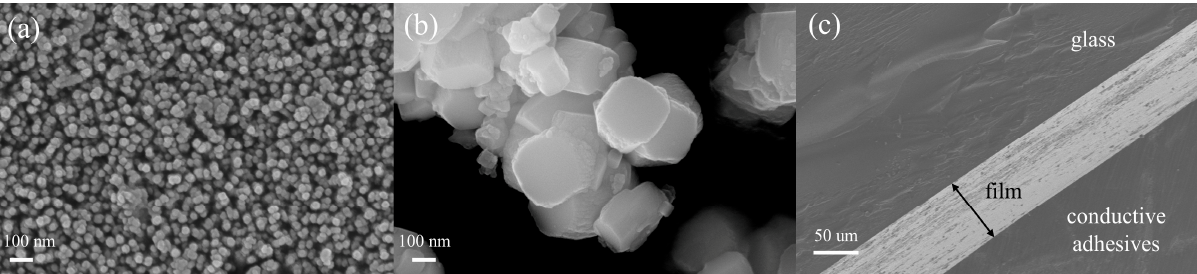
Figure 3. SEM images of ( a ) the top view of the TiO 2 film; ( b ) pure NaTaO 3 crystal samples prepared by hydrothermal method before heat treatment. ( c ) The cross-section image of the composite film.